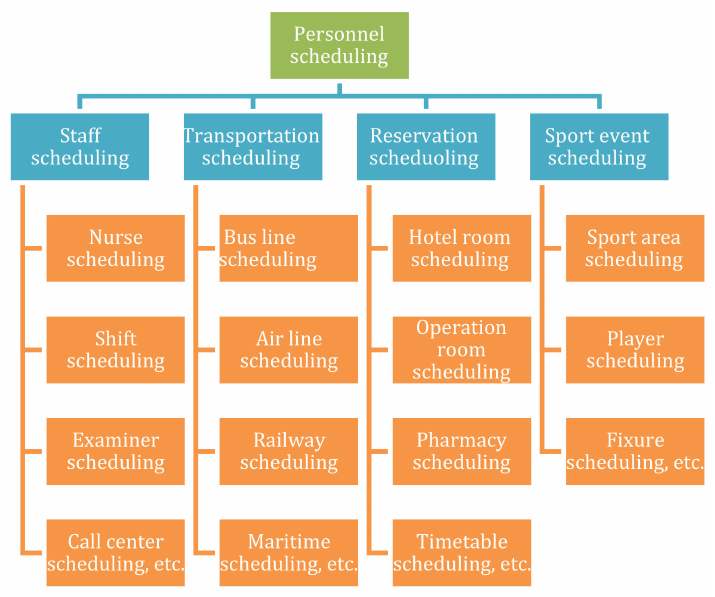
Figure 2. A classification of personnel scheduling